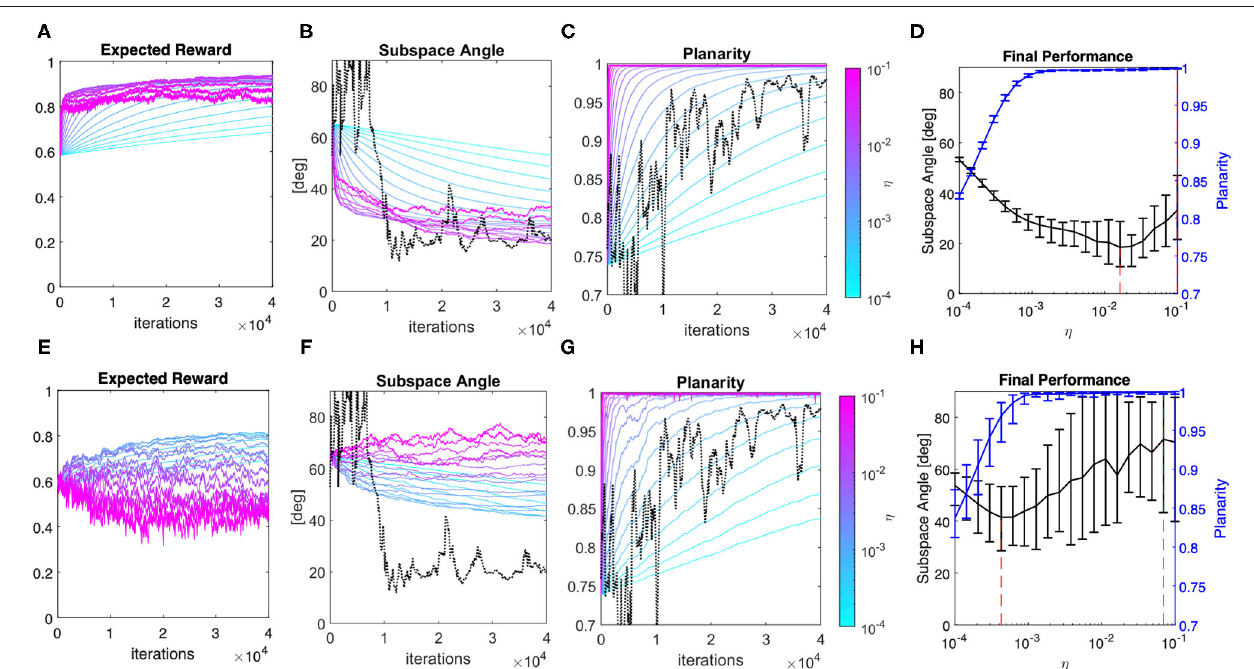
FIGURE 4 | User Model simulation: independent vs dependent data. Average expected reward, planarity, and subspace angle over 20 simulation runs of a model with varying learning rates generating a sequence of 40k independent (top row) or dependent (bottom row) data. Each model was simulated to evolve from the same initial condition as participant S8. (A,E) Expected reward computed over the generated sequences of independent and dependent data, respectively and averaged over the 20 simulation runs; (B,F) Subspace Angle between the 2D approximation of the simulated user’s covariance and the interface map at each learning iteration for independent and dependent samples, respectively; (C,G) Planarity index computed from the simulated user’s covariance matrix at each learning iteration for independent and dependent samples, respectively. The range of the learning rate parameter spanned an interval from to and the relative performance of the model is identified by a color that changes from light blue to pink for increasing learning rates, as indicated by the color bar. The dotted lines overlay the experimental metrics obtained from #S8, also reported in Figure 3 ; (D,H) summary of Planarity (blue line) vs. Subspace Angle (black line) obtained in the final 200 learning iterations at each learning rate in the case of independent and dependent samples, respectively. The solid lines represent the average value computed over the 20 simulation runs for each model, while the dispersion indicates the 95% confidence interval. The red dotted lines mark the best performing model for the two parameters considered.